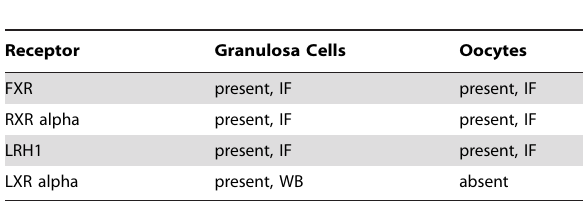
Table 2. Presence of receptors known to regulate the bile acids synthesis